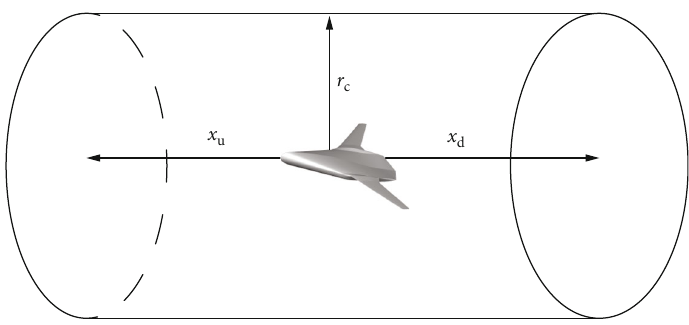
Figure 8: Integral volume for aerodynamic dissipation